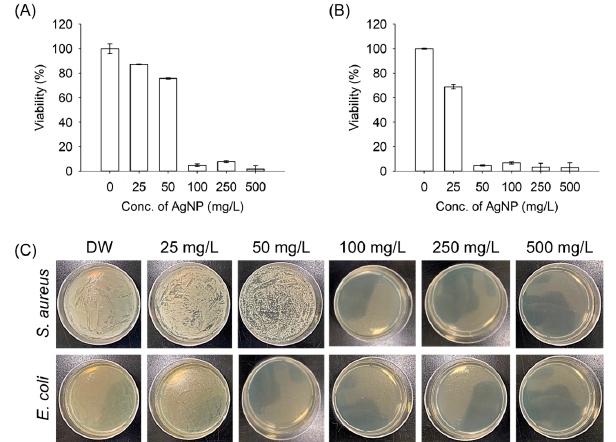
Figure 3. Antibacterial activity of AgNPs against bacterial strains. Quantitative antibacterial activity of AgNPs against ( A ) S. aureus and ( B ) E. coli ( n = 3). ( C ) Photographs of bacterial strains incubated with different AgNP concentrations and then grown on agar